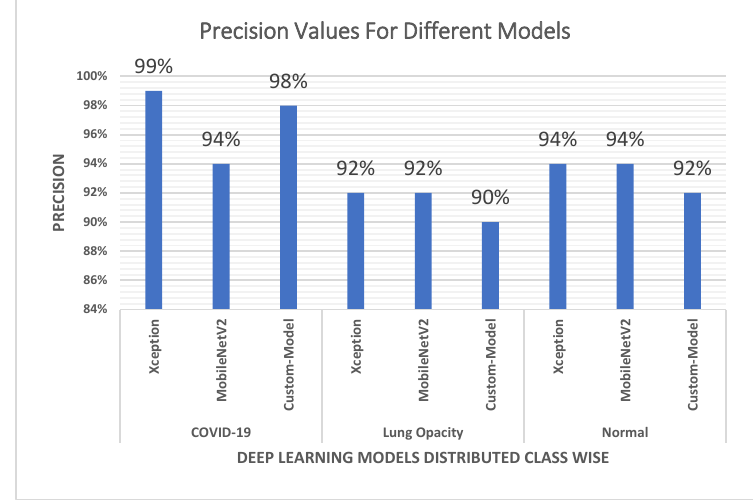
Figure 8. Precision plot for different models in terms of percentages.